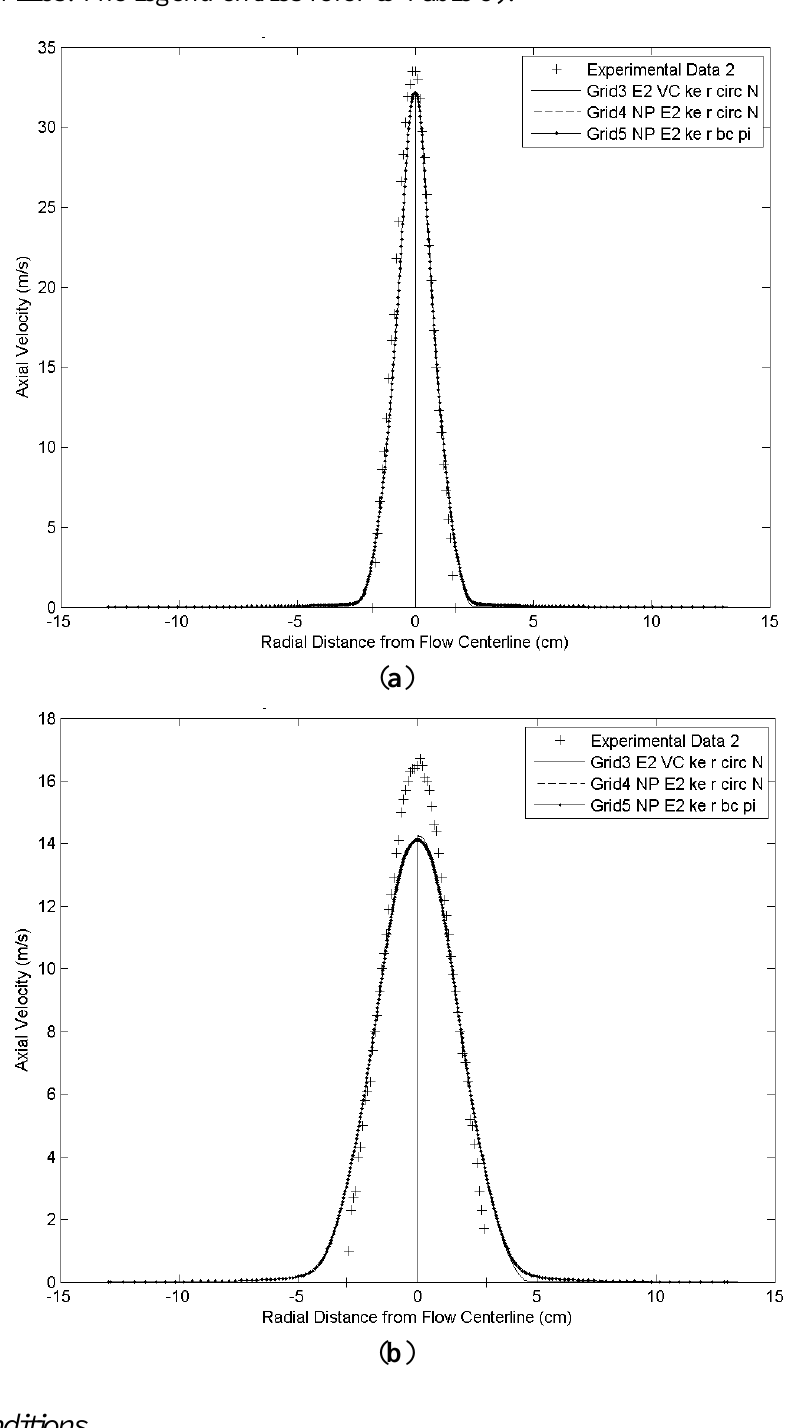
Figure 12. Axial velocity vs. radius ( a ) at 10 cm (comparison of results for the three grid families.The legend entries refer to Table 3); ( b ) at 20 cm (comparison of results for the three grid families. The legend entries refer to Table